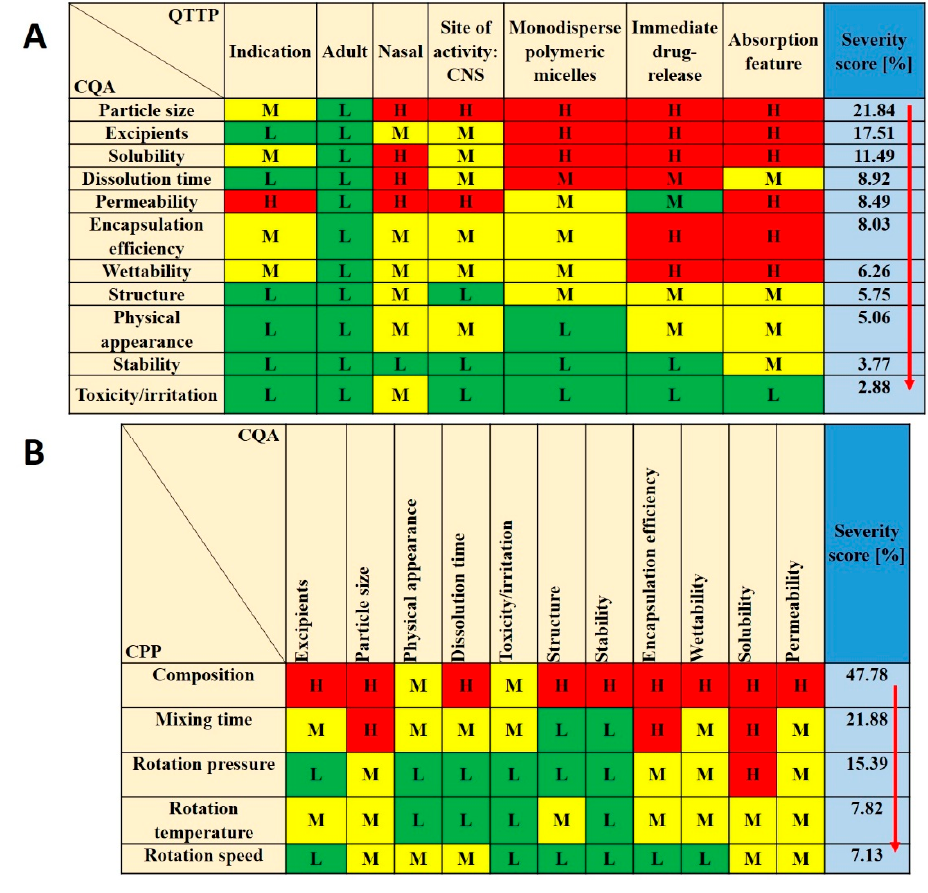
Figure 2. Risk assessment of the MEL-loaded polymeric micelles. ( A , B ) Interdependence ratings between ( A ) CQAs and QTTPs and CQAs and ( B ) CPPs with the calculated severity scores of CQAs and CPPs in decreasing order of risks. Abbreviations: QTPP—quality target product profile; CQA—critical quality attributes; CPP—critical process parameters; L—low; M—medium; H—high.